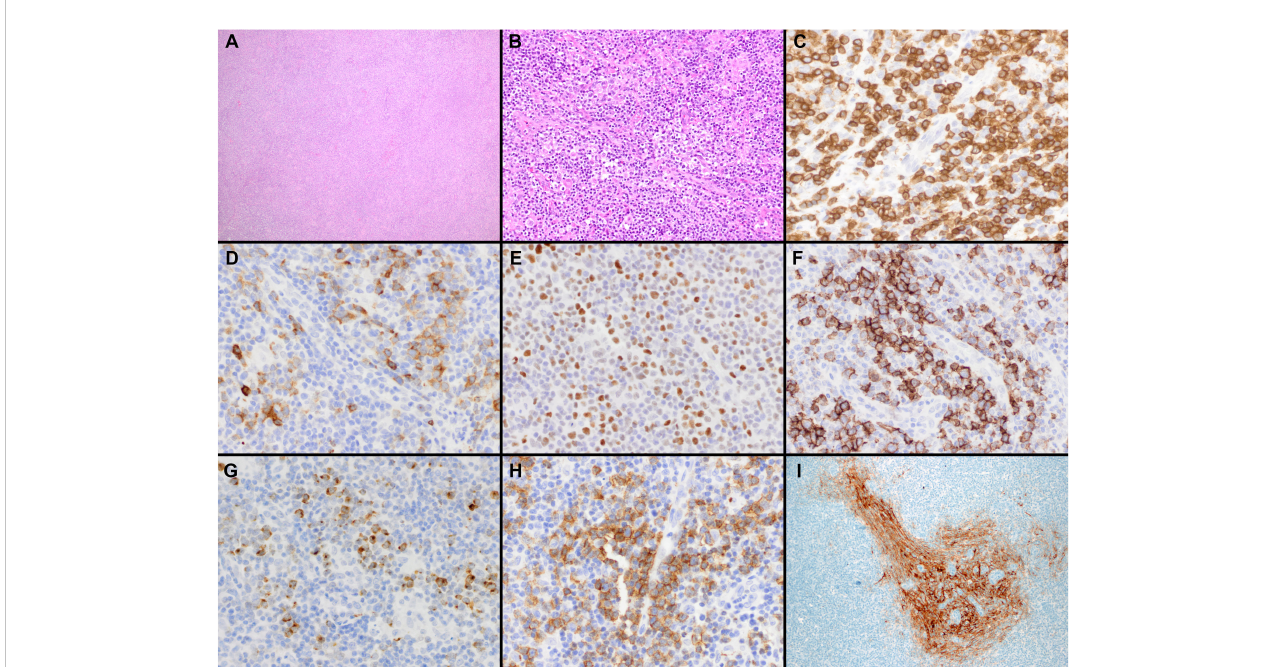
FIGURE 1 Histopathologic features of nodal T-follicular helper (TFH) cell lymphoma, angioimmunoblastic-type. (A, B) Hematoxylin & Eosin (H&E) shows that the neoplasm completely effaces the nodal architecture (A) ; the neoplasm is diffuse and composed of a heterogeneous cell in fi ltrate associated with numerous high endothelial venules (HEVs), in fl ammatory cells, and clusters of small lymphocytes with clear cytoplasm (B) (2x and 40x); (C) CD3 shows that most of the cells in the in fi ltrate are T-cells. Some of the T-cells are intermediate in size with irregular nuclear contours (40x); (D-H) The tumor cells are positive for CD10 (D) , BCL6 (E) , ICOS (F) , CXCL13 (G) and PD-1 (H) supporting a TFH immunophenotype (all 40x). Note the clustering of the tumor cells around the HEVs. (I) CD21 highlights focally expanded follicular dendritic cell meshworks surrounding HEVs